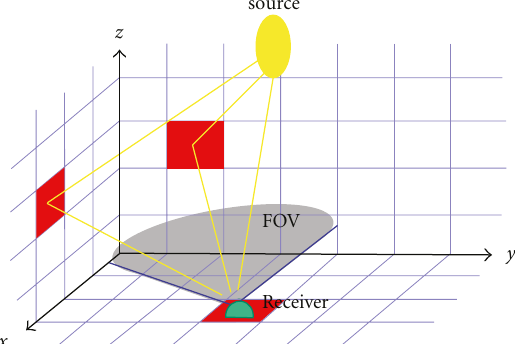
Figure 3: A di ff usive optical link with the geometry of source and receiver and ray tracing between reflector and receiver